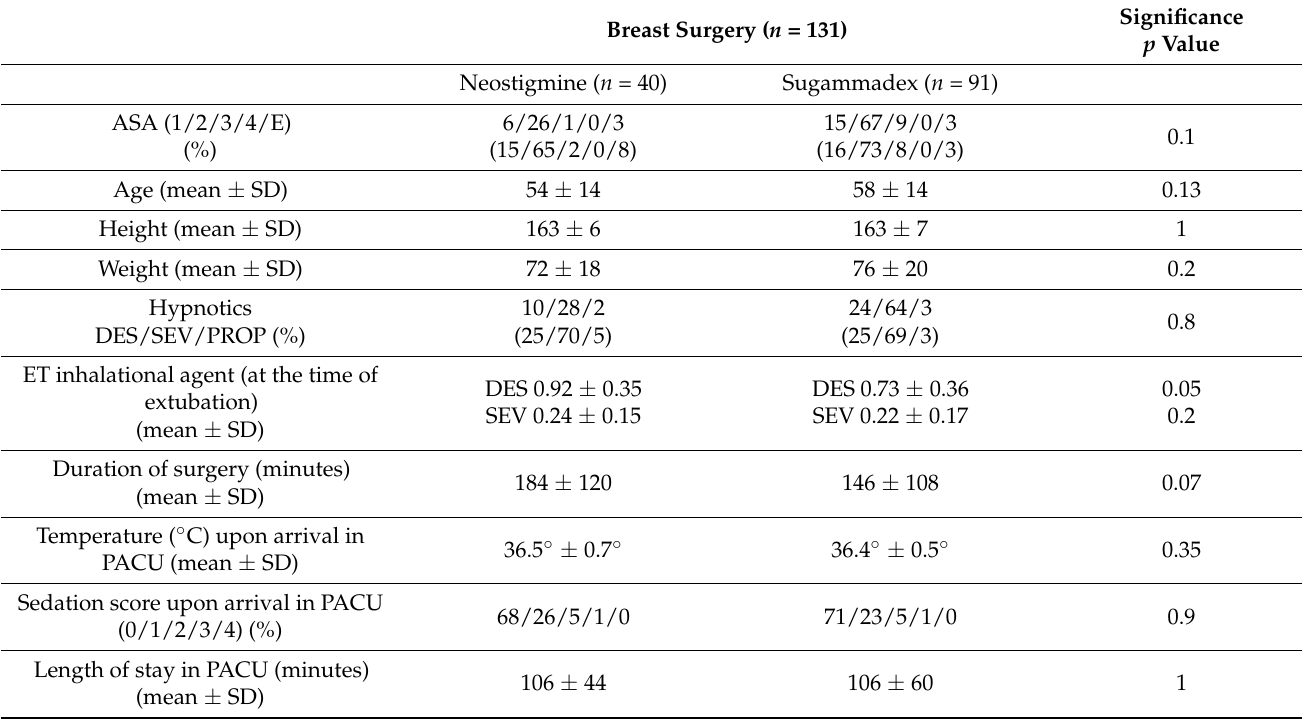
Table 1. Demographic characteristics for breast surgery patients. Breast Surgery ( n = 131)